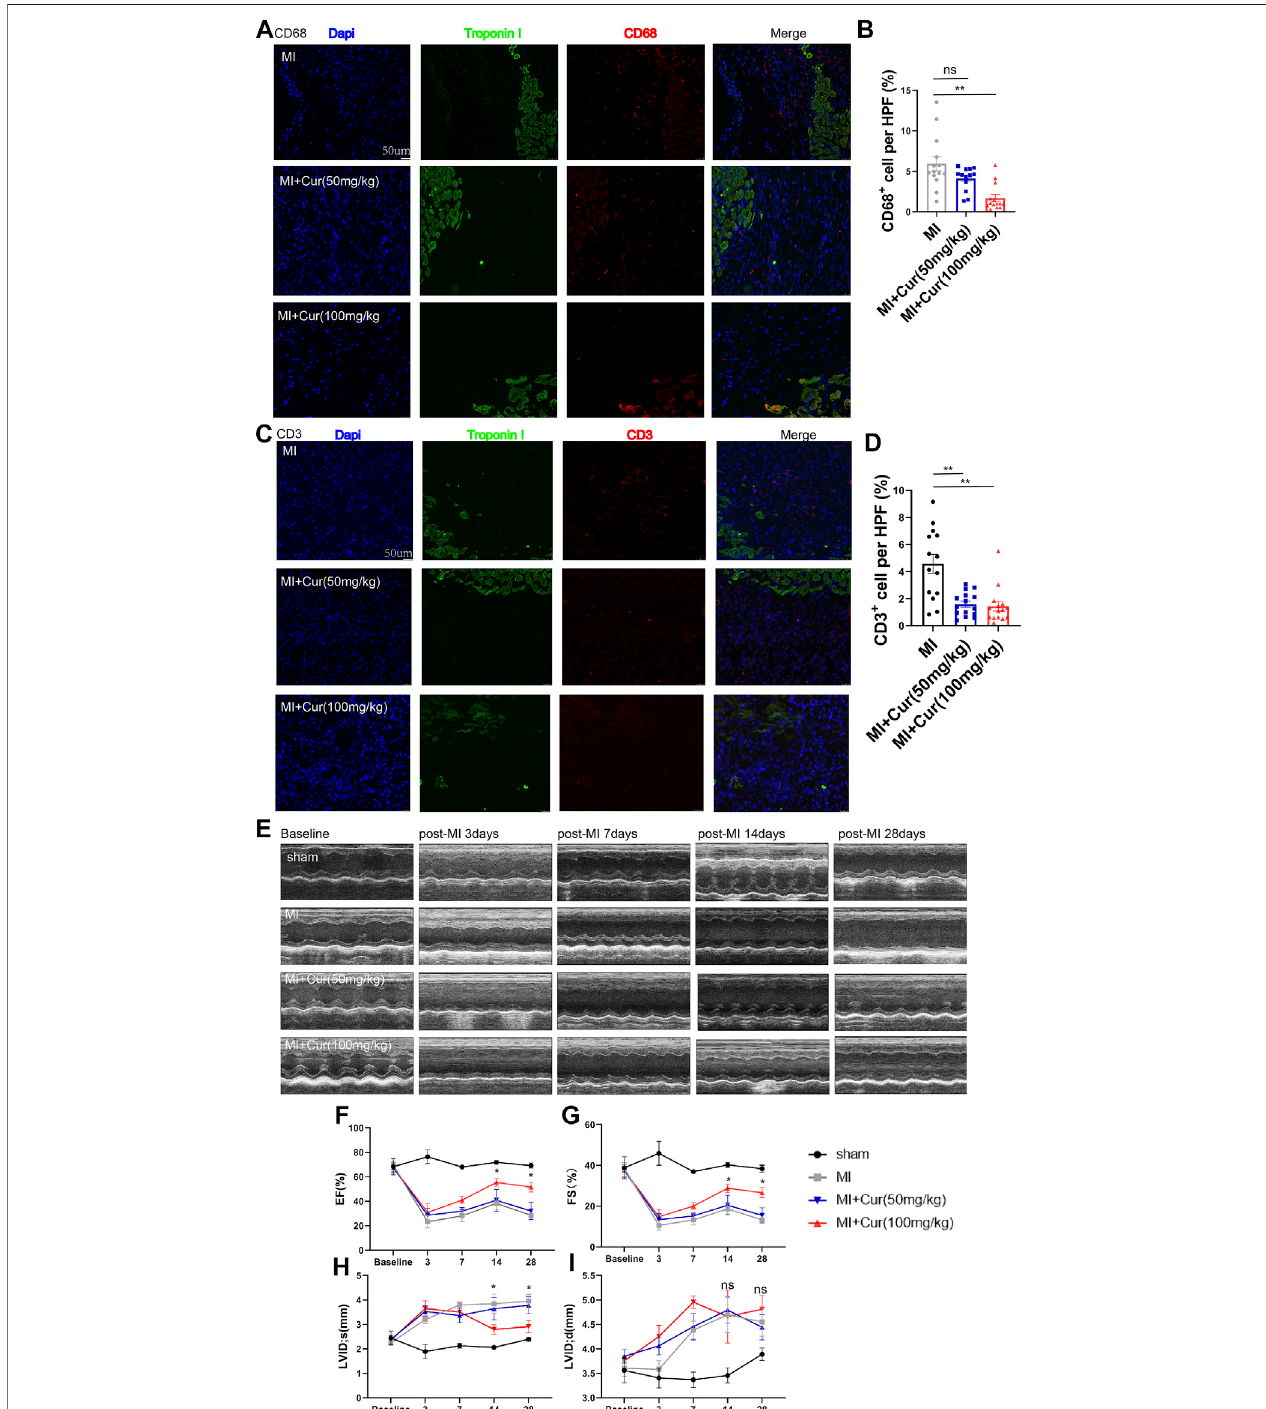
FIGURE 1 | Curcumin administration ameliorates in fl ammatory response in acute phase post-MI and preserves long-term cardiac function (A). Macrophage counts re fl ected by CD68 staining (red) in peri-infarct heart samples harvested 7 days post-MI from C57 mice in respective group (MI, MI + Cur 50 mg/kg, MI + Cur 100 mg/kg). Troponins wereidenti fi edby green coloring; statistical dataare summarized in (B). n (cid:1) 4-5in each group (C). Tcell counts re fl ected byCD3 staining(red) in peri-infarct heart samples harvested 7 days post-MI from C57 mice (MI, MI + Cur 50 mg/kg, MI + Cur 100 mg/kg). Troponins were identi fi ed by green coloring; statistical dataare summarized in (D). n (cid:1) 4-5in each group (E). M-mode representative graphsfrom echocardiography conductedon MI, MI+ Cur 50 mg/kg, MI +Cur 100 mg/kg, respectively. Echocardiography were conducted at baseline and 3, 7, 14, and 28 days post-MI. Cardiac function re fl ected by left ventricle ejection fraction (LVEF%) and left ventricle fraction shortening (LVFS%) in each group (MI, MI + Cur 50 mg/kg, MI + Cur 100 mg/kg) are plotted in (F) and (G) . n (cid:1) 5 in each group (H-I). Leftventricularinternaldimensioninsystolicphase(LVIDs)andLeftventricularinternaldimensionindiastolicphase(LVIDd)ineachgroupatdifferenttimepointwerealso plotted in (H) and (I) . MI: myocardial infarction. Results are mean with SEM. NS (cid:1) no signi fi cance between groups, * p < 0.05, ** p < 0.01.